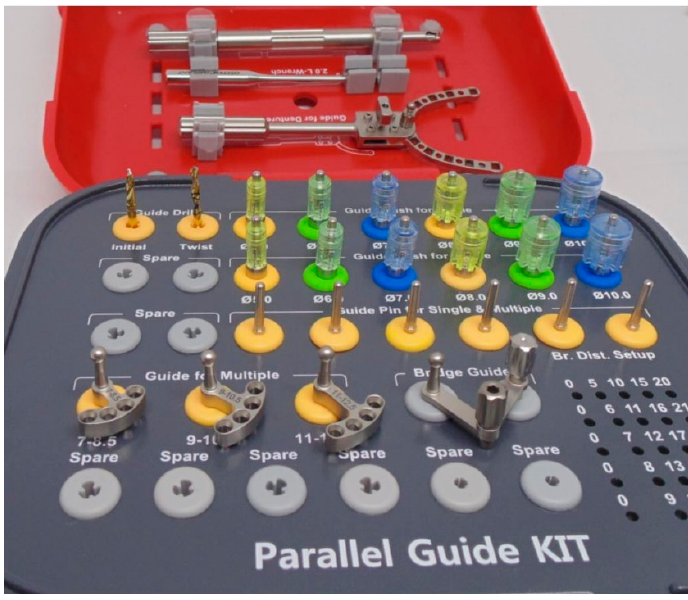
Figure 1. Kit includes: 2 twist drills, plastic sleeves in diameters 6 to 10 mm corresponding to the mesiodistal dimensions of di ff erent teeth, fixed parallel distancers from 7 to 12.5 mm, adjustable distancer for bridges, adjustable guide for edentulous ridges, parallel pins, and holders.